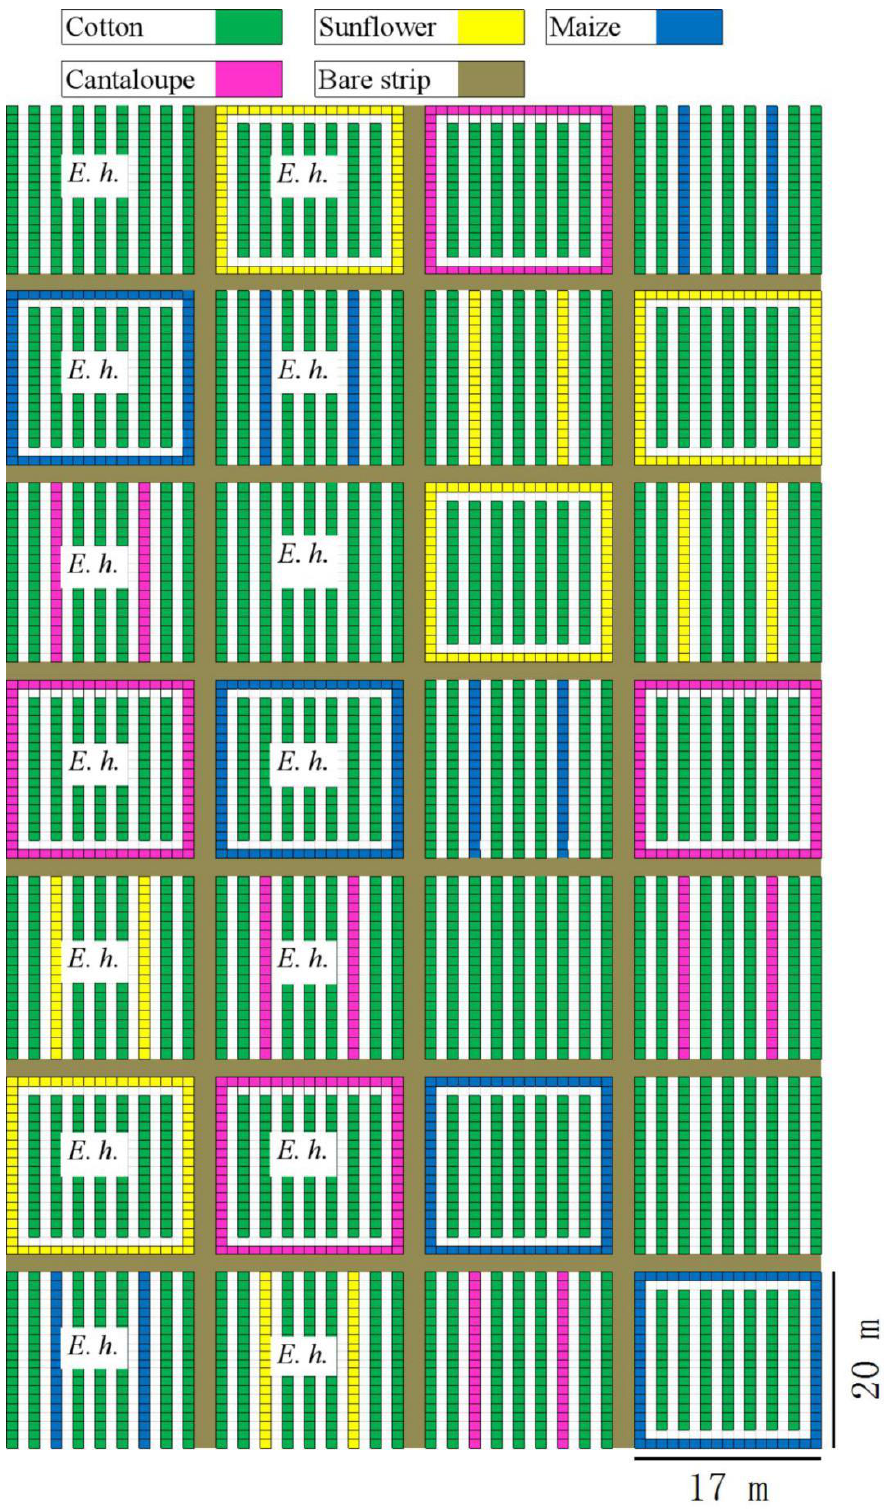
Figure 1. Spatial layout of the field experiment. E. h. indicate that Eretmocerus hayati was released in this plot. Plots (17 × 20 m) consisted of nine rows of planting beds, each 20 m long and 1 m wide, separated by 1 m from each other. Each bed was planted with two rows of cotton plants, and each row was planted with 60 plants 33 cm apart. Plots were separated from each other by a 2 m wide bare strip.